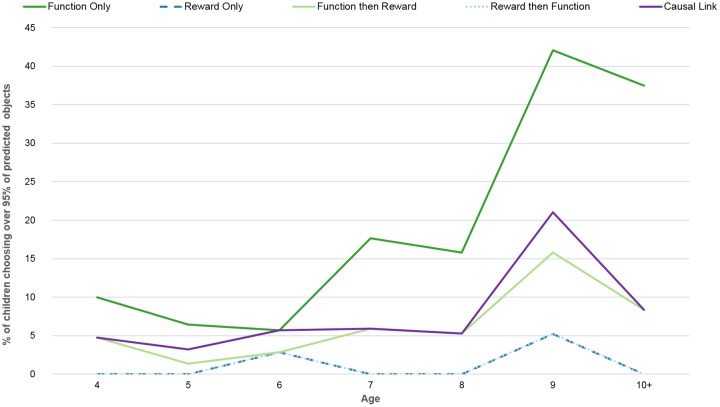
Percent of children choosing over 95% of objects predicted by a given model.